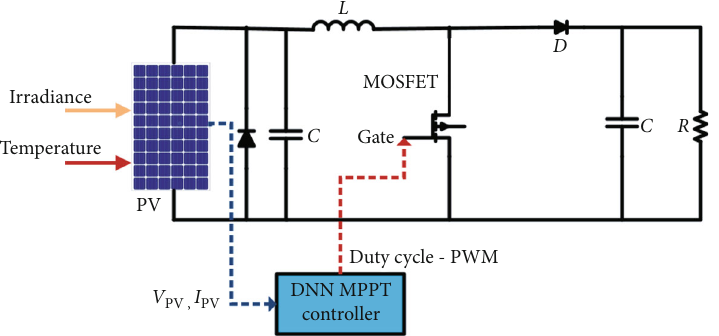
Figure 2: Proposed DNN-based MPPT